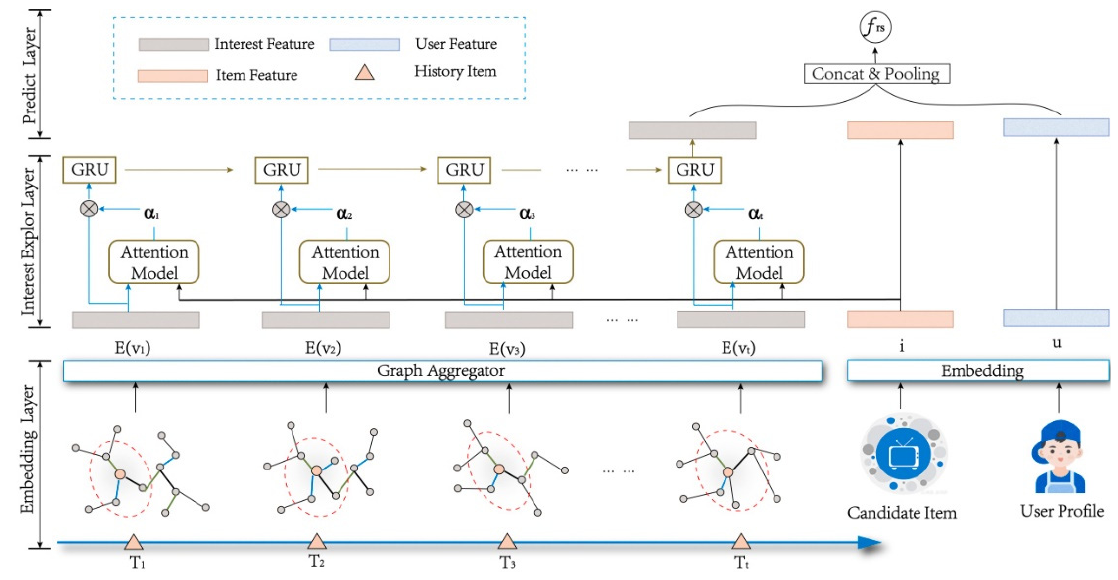
Figure 2. The Framework of DINK